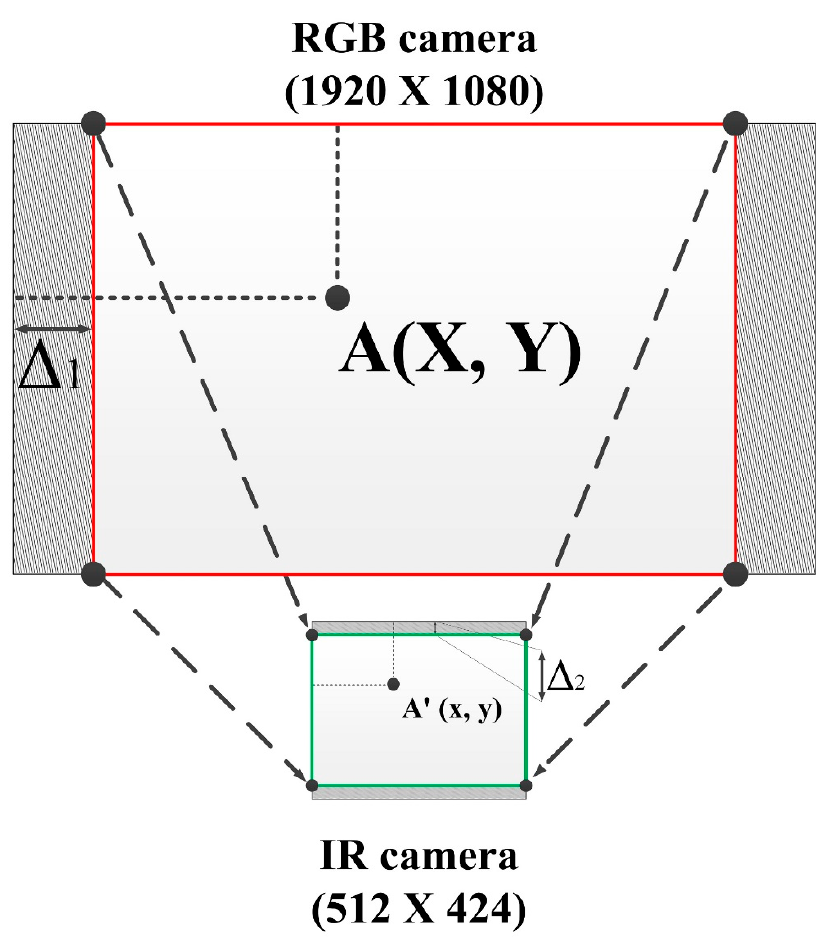
Figure 11. Demonstration of mapping methodology for Kinect v2.